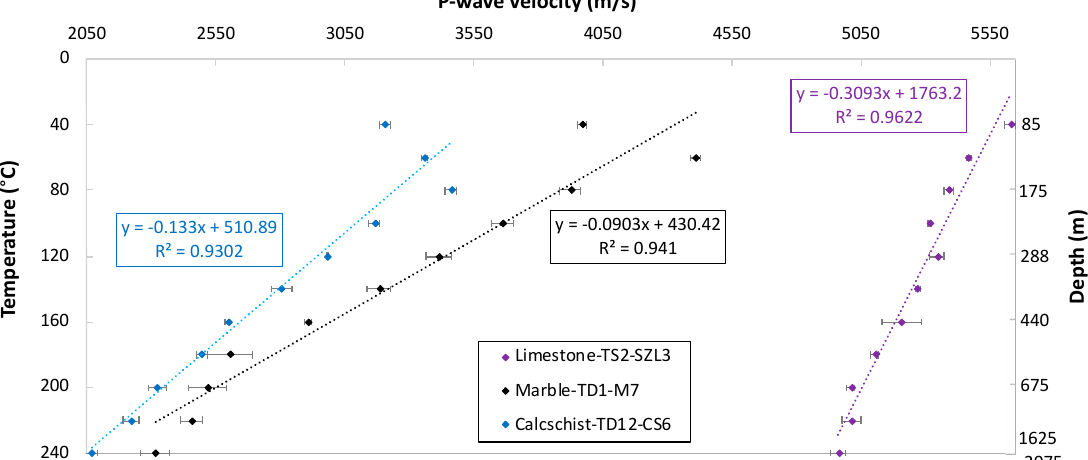
Figure 12. P-wave velocity as a function of temperature ( ◦ C), and thus depth below the surface, for the limestone (purple), marble (black), and calcschist (blue) samples assessed. For all three experiments, a linear regression has been applied to the data. A total of three to five measurements were taken every 20 ◦ C. The error bars shown represent the standard deviation, whereas the actual data points denote the averaged seismic velocity. Non-linear temperature–depth relationship is taken from [36].